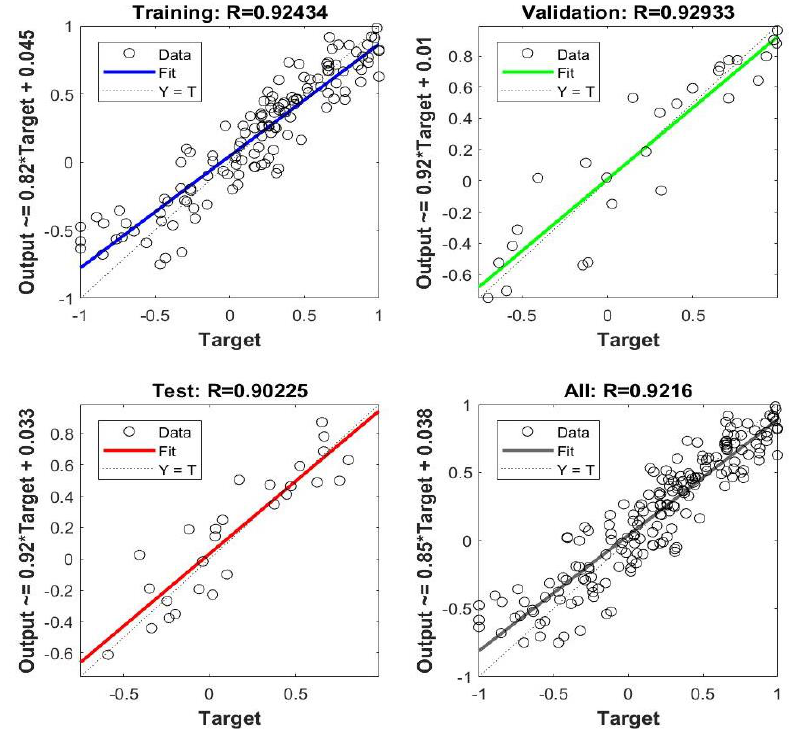
Figure 3. Regression analysis of the ANN model by program: R is the correlation coefficient.